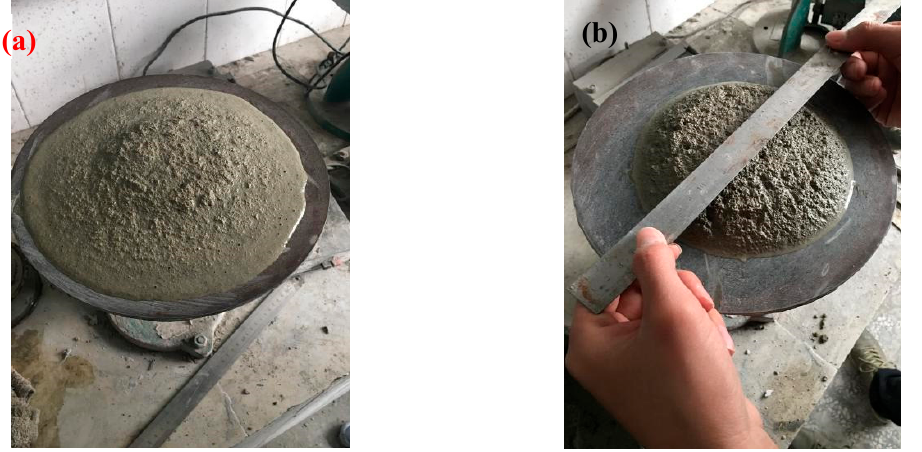
Figure 2. Photos of flowability testing: ( a ) GO-modified natural NS-based mortar (GONM) slurry without GO; ( b ) GONM slurry with w GO = 0.05 wt‰.